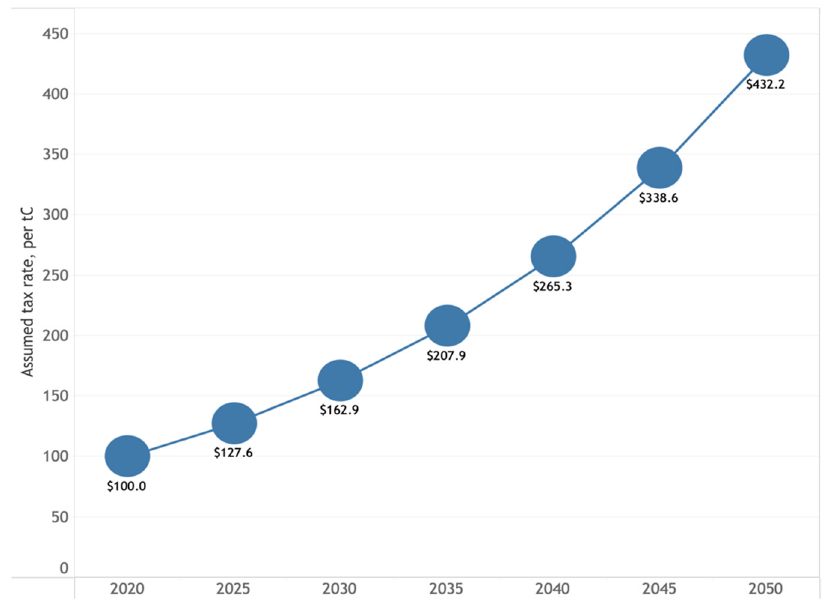
Figure 2. Emissions tax rates, set globally, by model year. We allow the tax to start at $100/tC and increase by 5% annually.